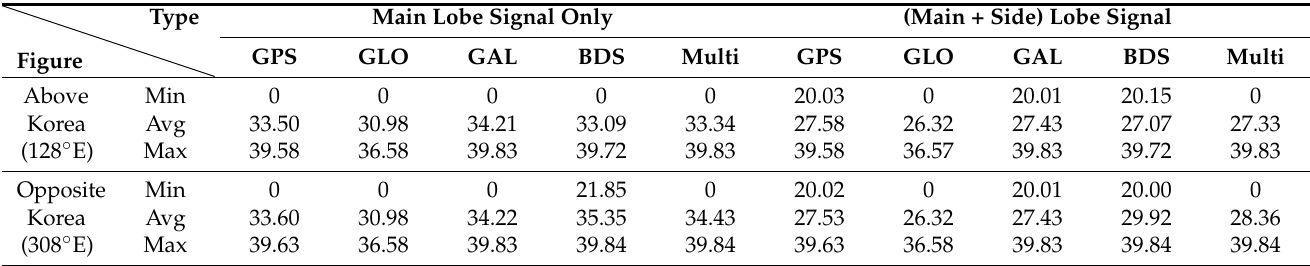
Figure 10. 𝐶 / 𝑁 0 for 24 h in geostationary orbit. Figure 10. C / N 0 for 24 h in geostationary orbit. Table 4. C/𝑁 (cid:2868) [dB-Hz] for 24 h in geostationary orbit. Table 4. C / N 0 [dB-Hz] for 24 h in geostationary